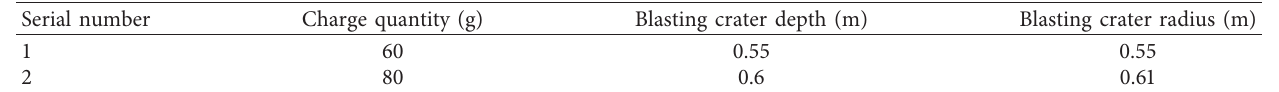
Figure 15: Rock cracks caused by different charge quantity: (a) 60g and (b) 80g. Table 4: Parameter table of blasting effect of single blast hole.